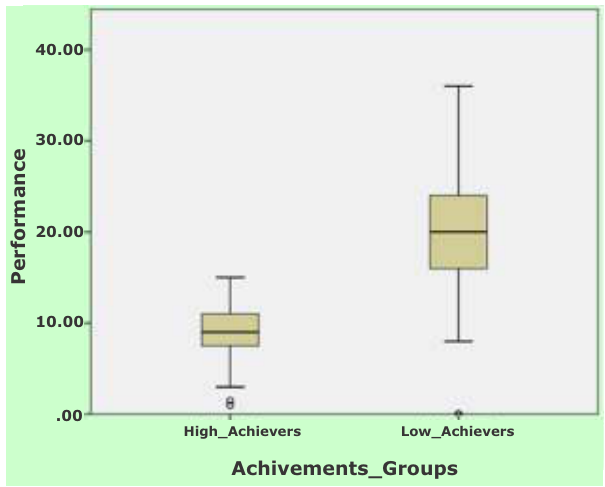
Figure-I: Combined whisker plot for high & low achievers in online teaching.